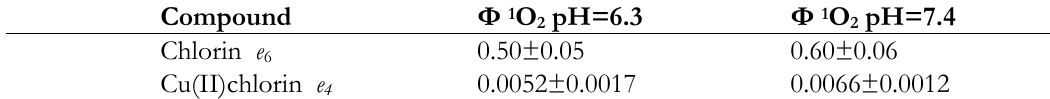
Cu(II)chlorin e 4 was excitated at λ 431nm with λ